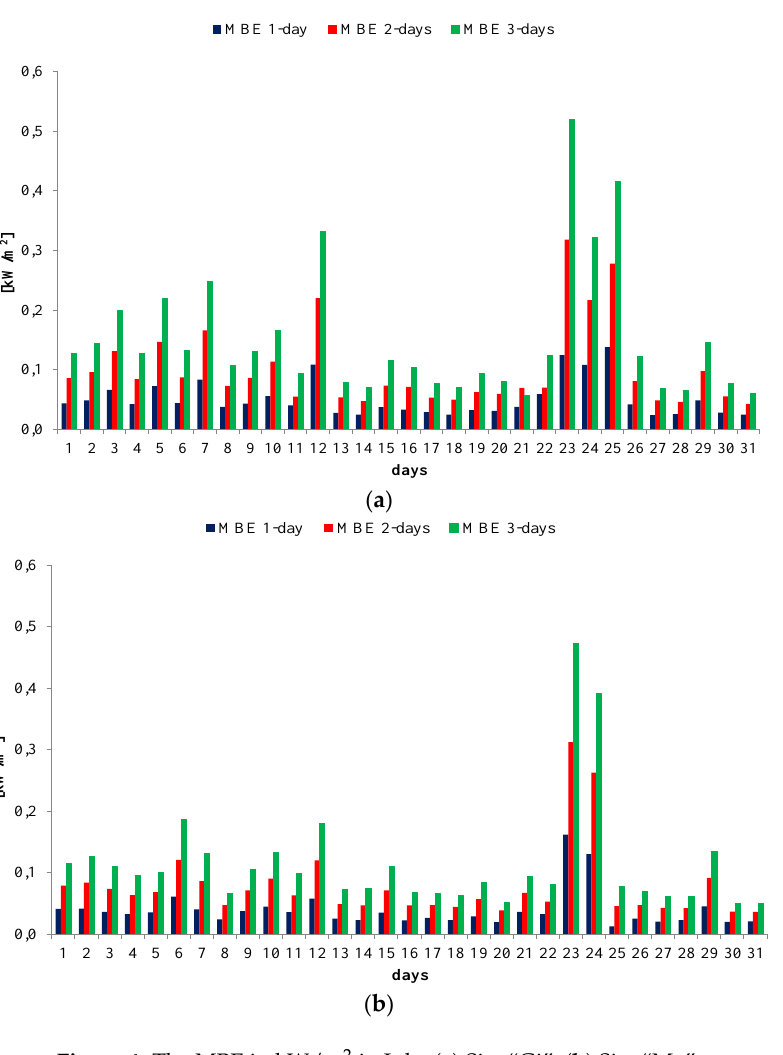
Figure 4. The MBE in kW/m 2 in July. ( a ) Site “Gi”; ( b ) Site “Ma”.